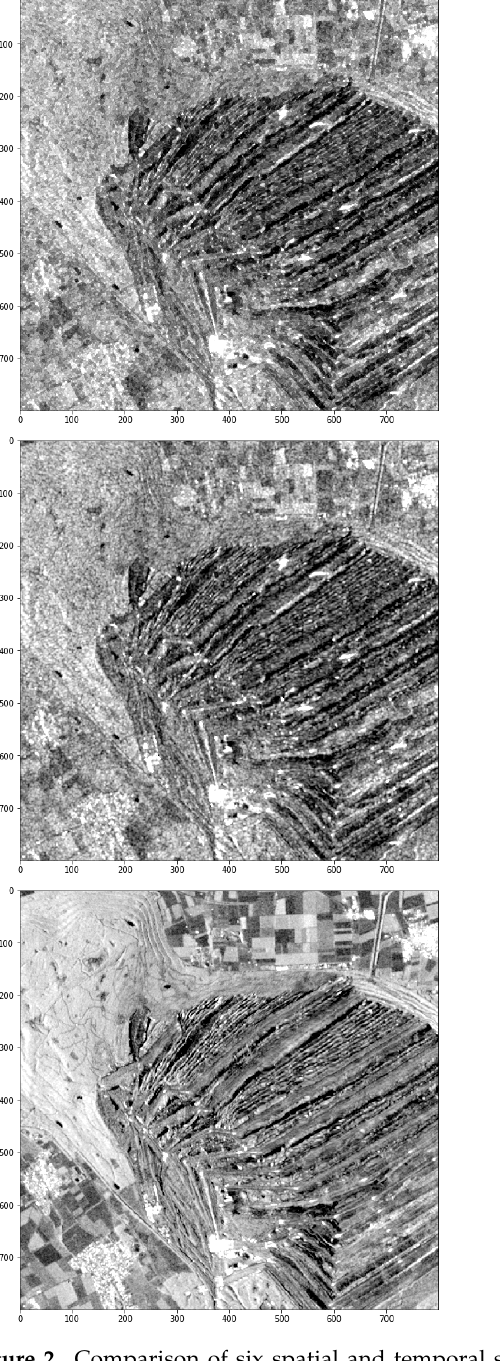
Figure 2. Comparison of six spatial and temporal speckle filters: Refined Lee ( top left ), Gamma MAP ( top right ), Frost ( center left ), empirical mode decomposition (EMD) ( center right ), Quegan ( bottom left ), and ATSF ( bottom right ) for a spatial subset of the reference image, | S vv | 2 band only. Note that the earth moving machines are absent in both the Quegan and EMD